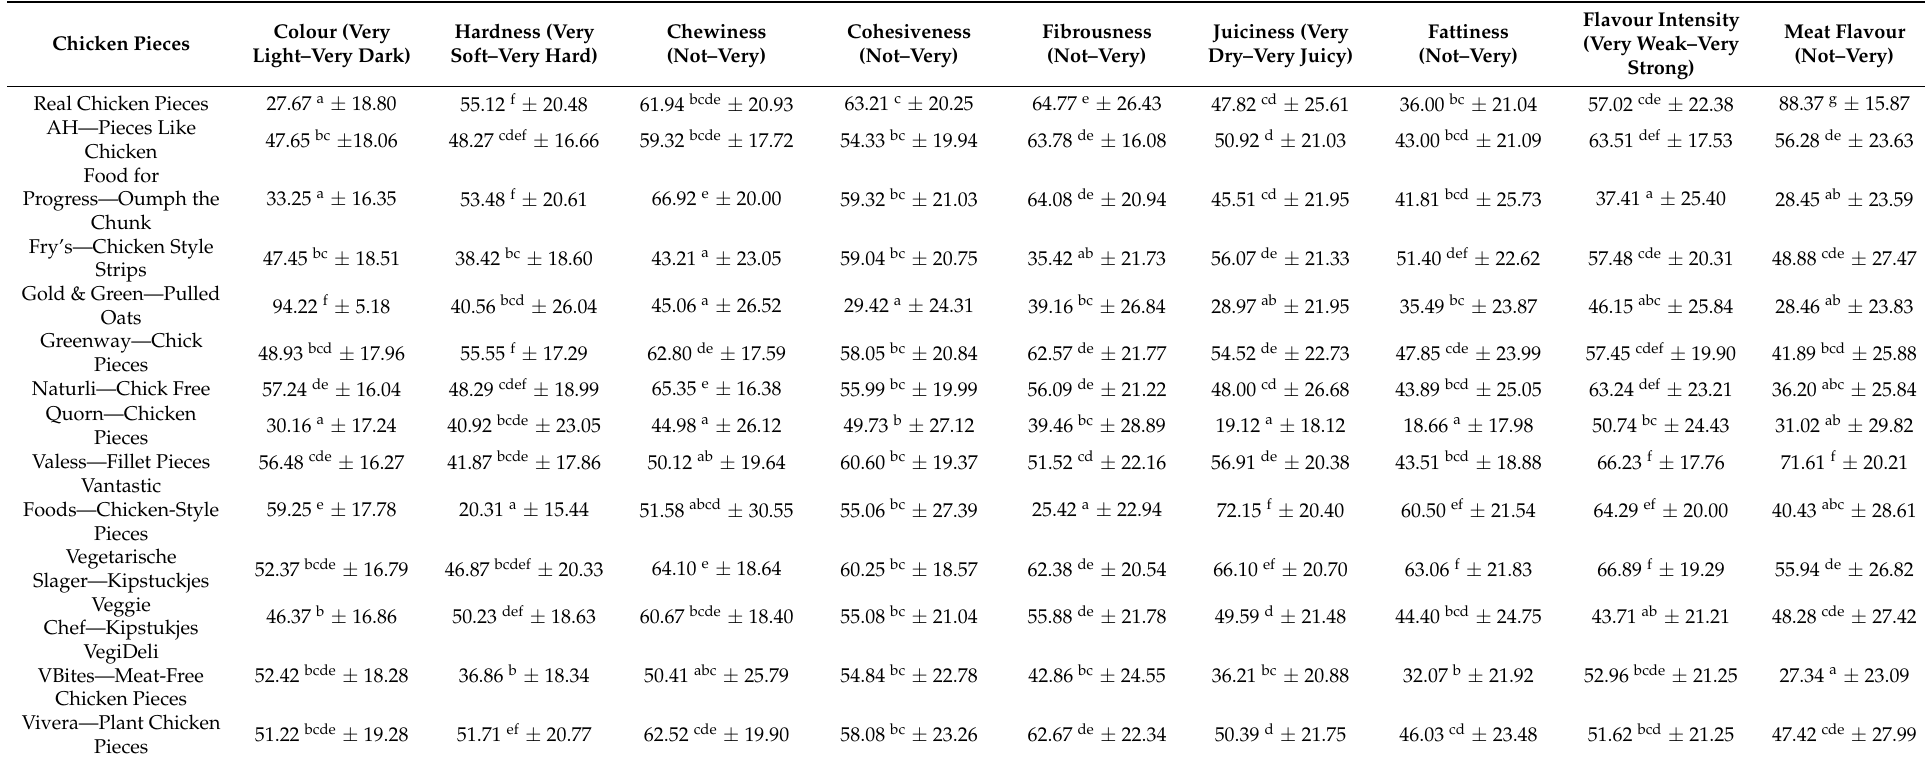
Table 5. Scores of the sensory attributes (scale: 0–100) assessed for the meat analogues studied in the present research ( n = 71). Different letters refer to statistical differences for the different parameters in the